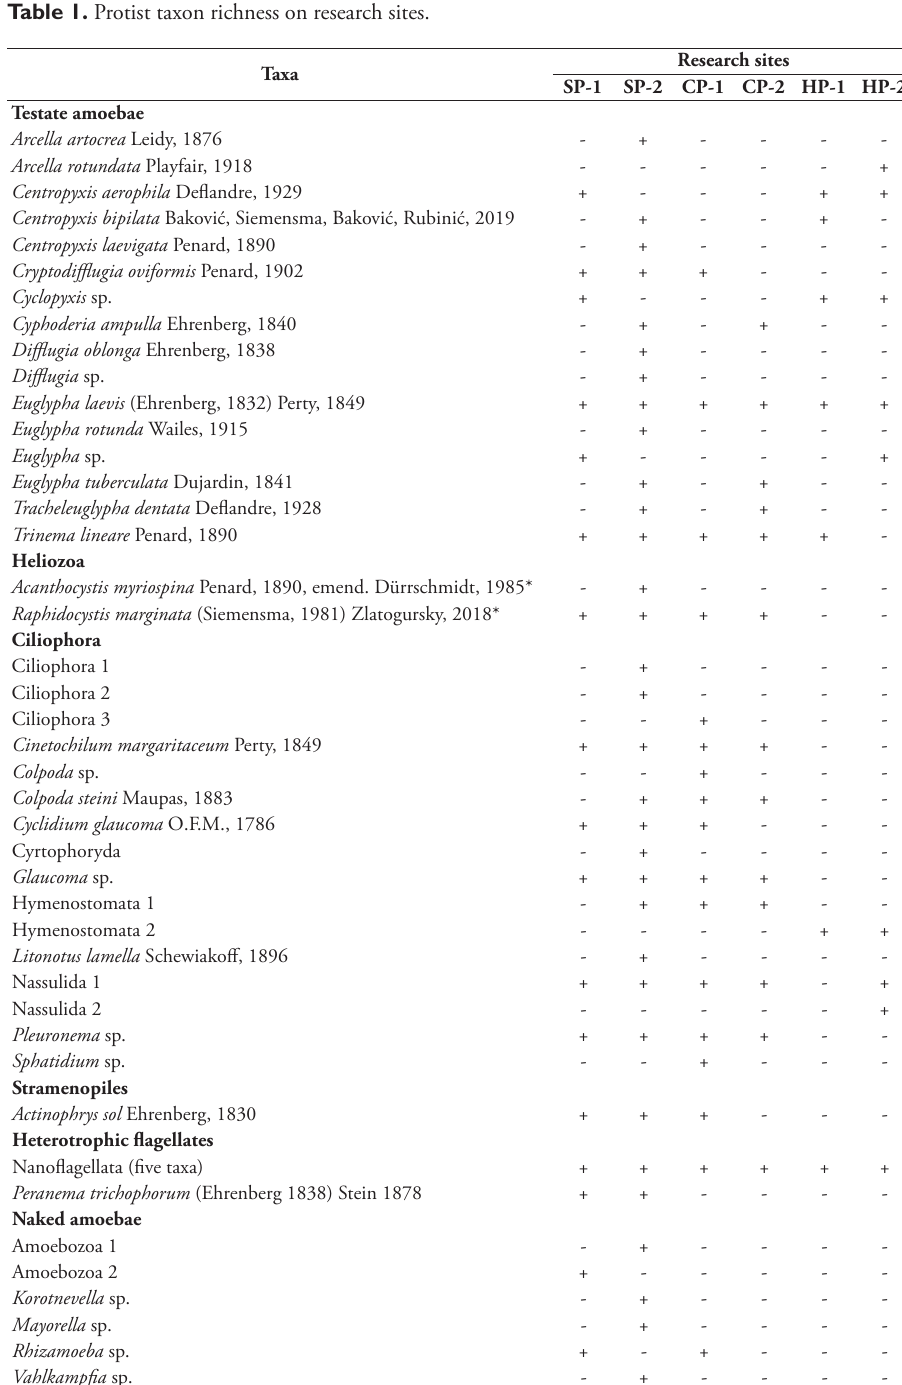
Table 1. Protist taxon richness on research